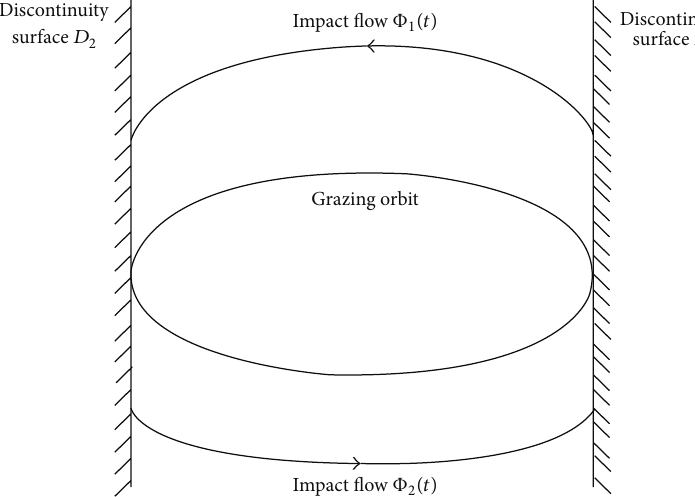
Figure 4: A schematic of the flow with